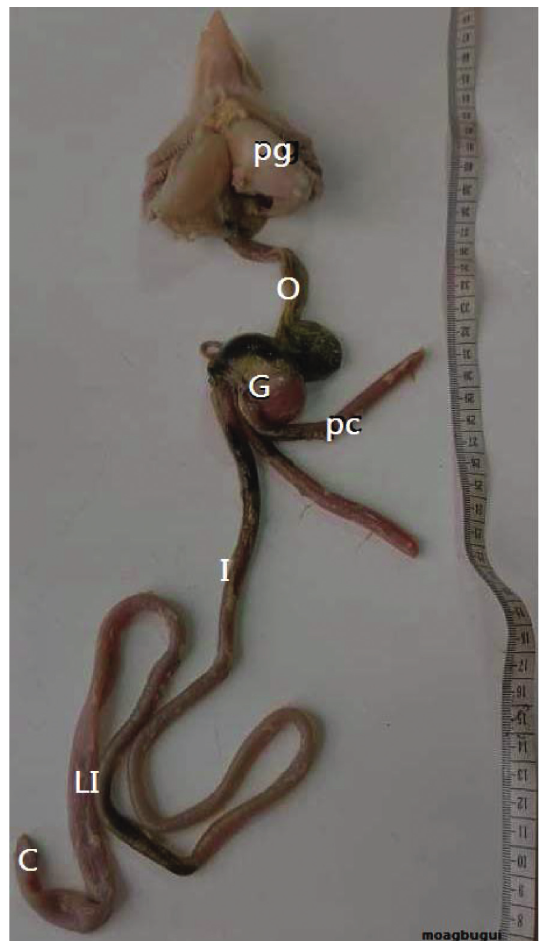
Figure 7: The detached GITof H. niloticus . pg, pouch of gills; O, oesophagus; G, gizzard-like stomach; pc, pyloric ceca; I, intestine; LI, large intestine, C, cloaca.